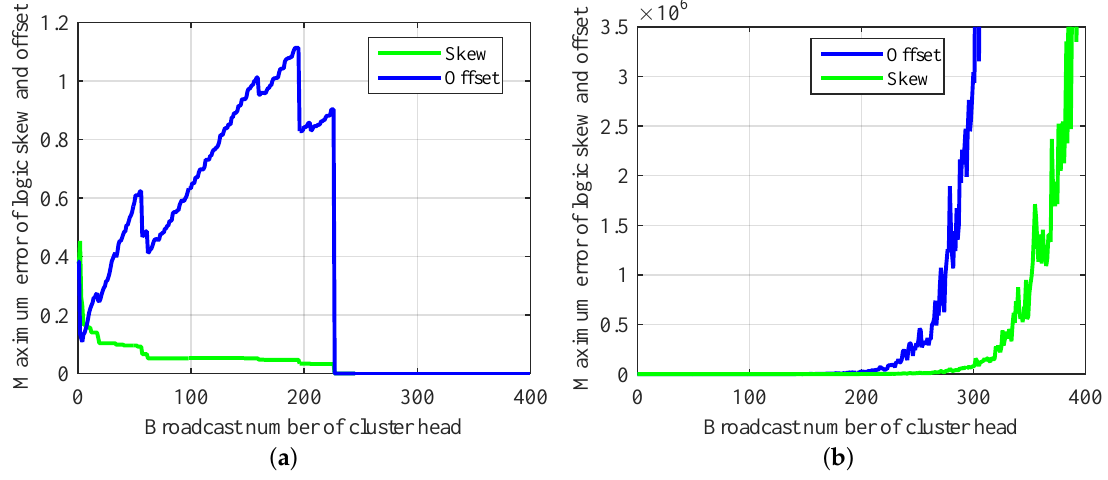
Figure 8. Comparison the property of Revised-CMTS and CMTS in intra-cluster time synchronization. ( a ) Revised-CMTS; ( b ) CMTS.